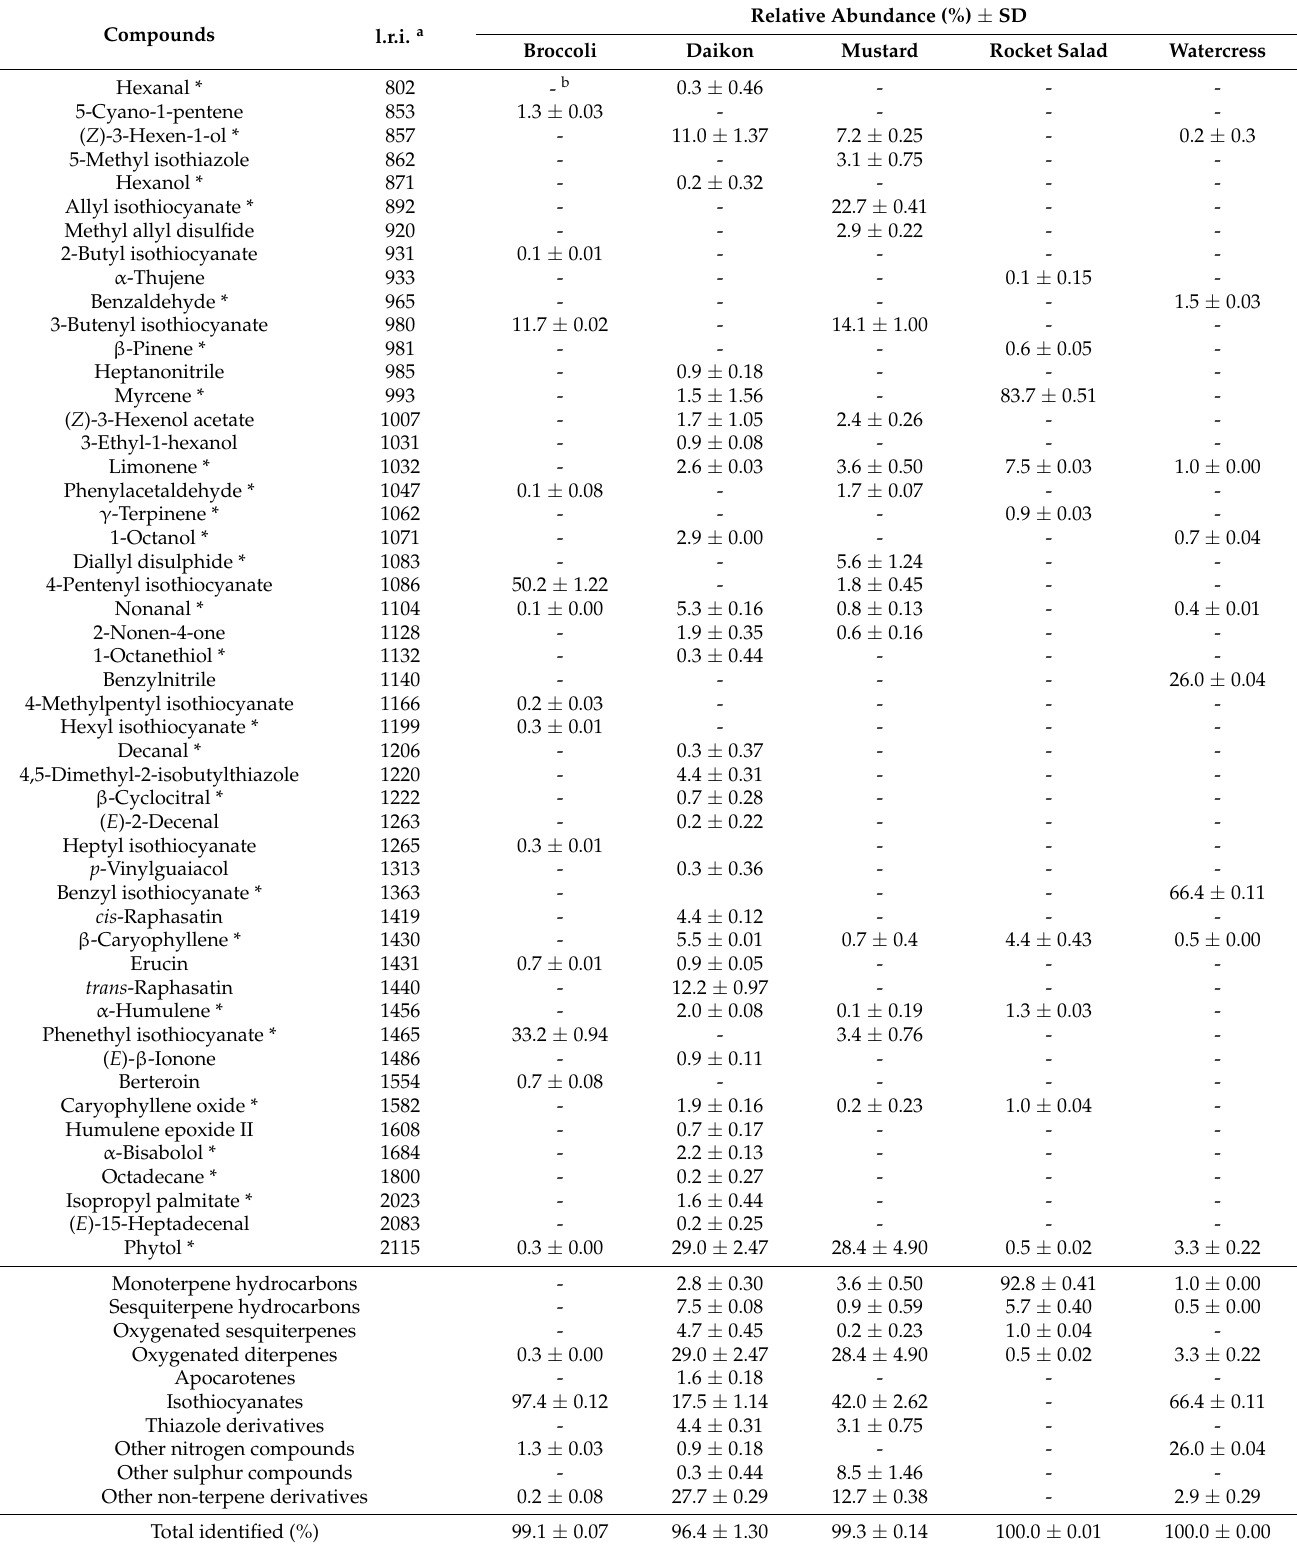
Table 2. Complete EO compositions for all of the analyzed